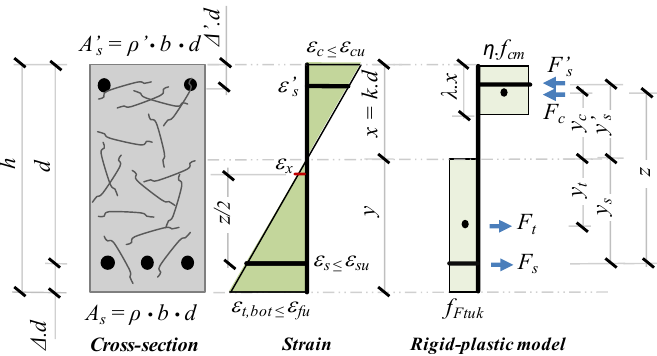
Figure 1. Flexure model of Model Code 10